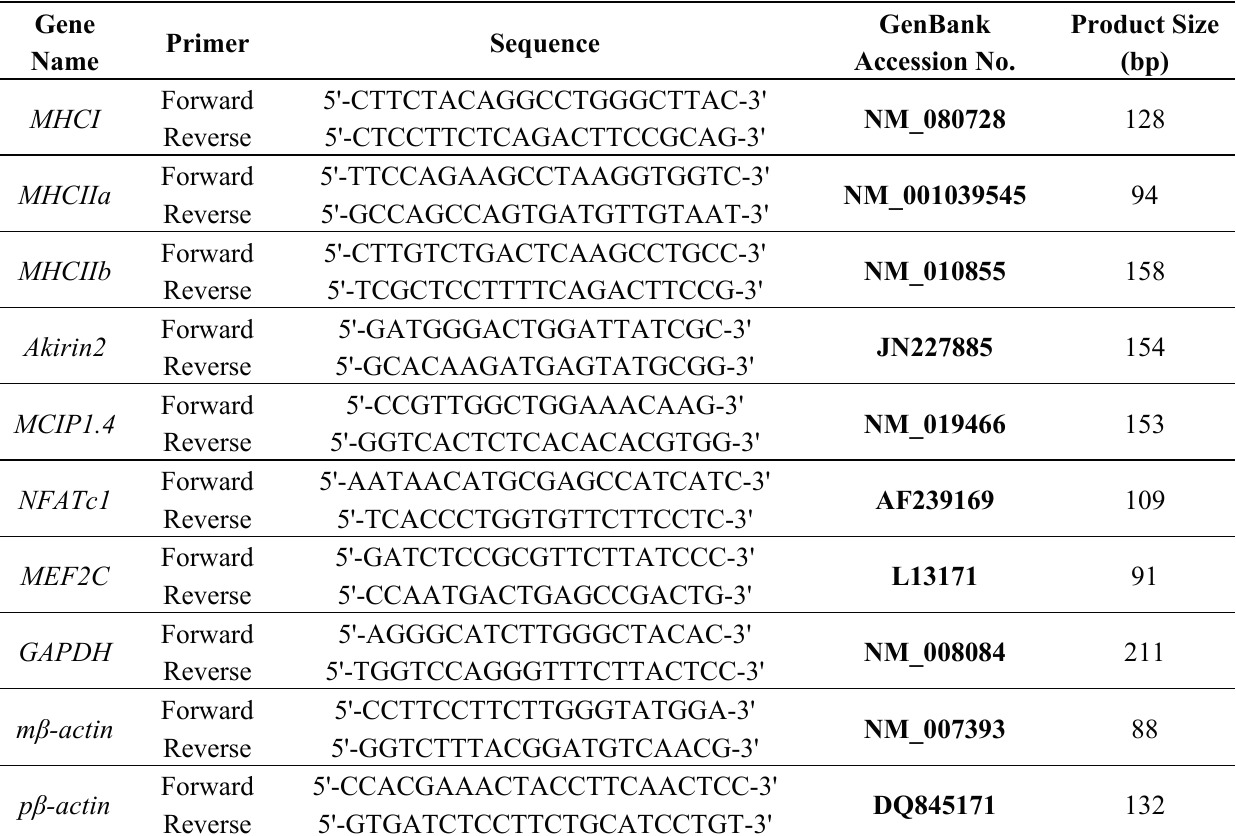
Table 1. List of genes, primer sequences, GenBank accession numbers, and product sizes in this study.